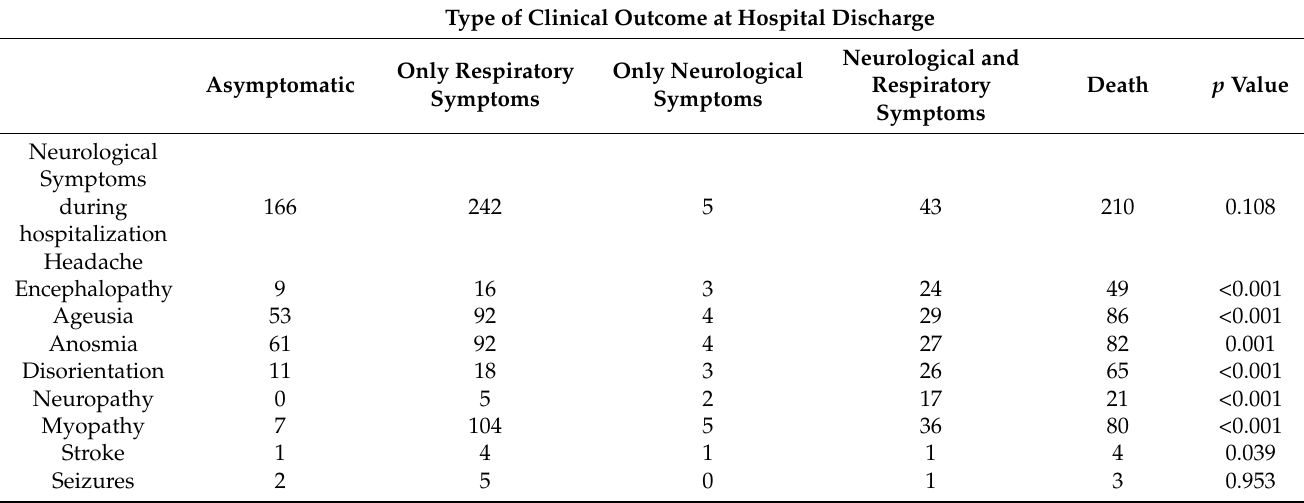
Table 4. Neurological symptoms during hospitalization and clinical outcomes at hospital discharge.